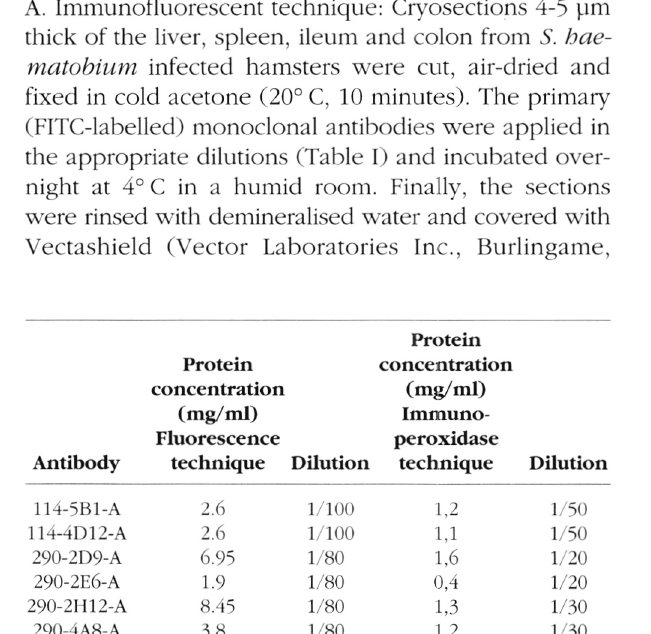
Table I. - Antibodies used for immunohistochemistry and dilutions